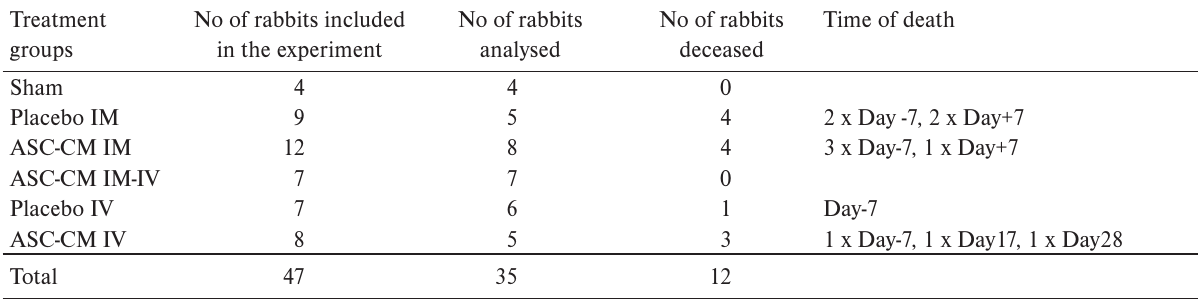
Table 3. Distribution of rabbits to the treatment